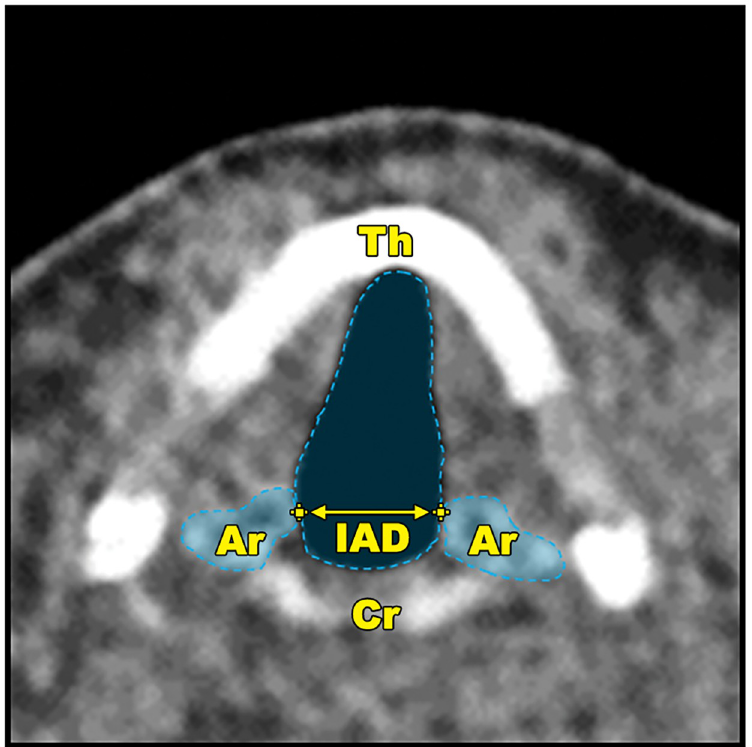
Fig 1. The laryngeal measures. Annotated CT image at the level of the glottis depicting the laryngeal measures used in this study. Fiducial markers (shown as yellow crosshairs) are placed at the most medial aspect of the arytenoid cartilages (Ar). The inter-arytenoid distance ( IAD ) is defined as the Euclidean distance between them, as depicted by the arrow. The arytenoid velocity ( av � ! ) is equivalent to the change in IAD between successive timepoints (not illustrated). The glottic area ( GA ) is the segmented area of air density at the level of the vocal folds. Also shown are the thyroid cartilage (Th) and cricoid cartilage (Cr).